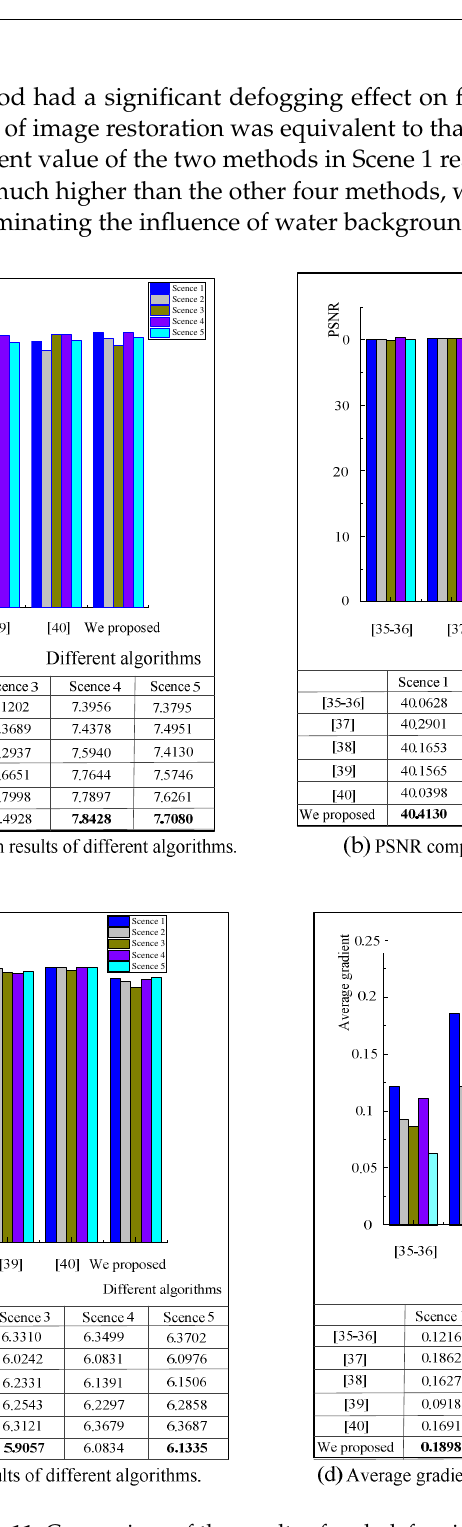
Figure 11. Comparison of the results of each defogging algorithm in different environments.